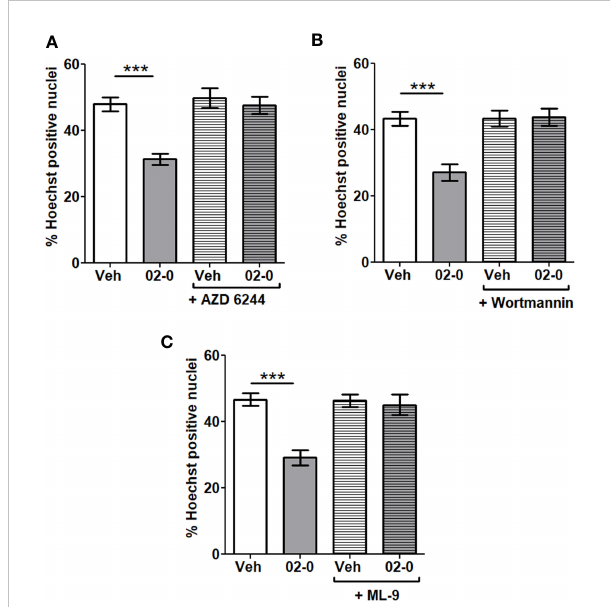
FIGURE 4 Involvement of signaling pathways in mPR a -mediated neuroprotection (A) Assessment of cell death in SH-SY5Y cells following Veh and 100 nM 02-0 24 h treatments in the presence of 50 m M 6-OHDA, with or without 1 m M AZD 6244. N=18. Two-way ANOVA results: Interaction: p=0.0039, Treatment: